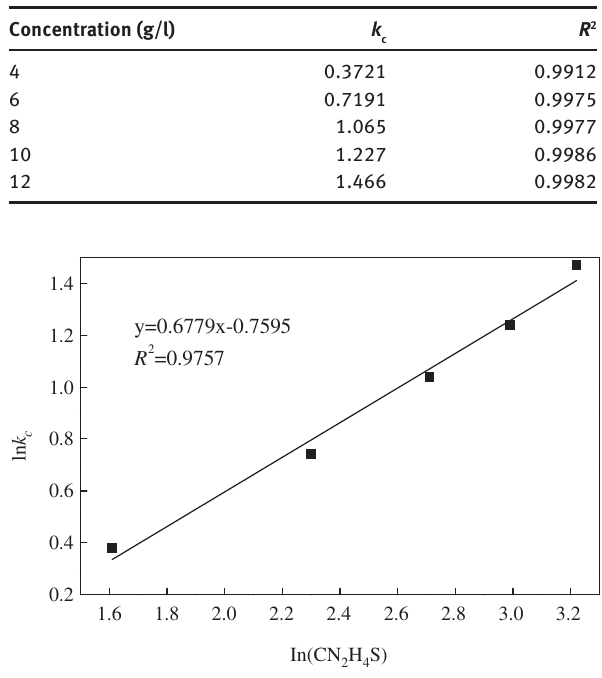
Figure 10: Estimation of reaction order with respect to thiourea